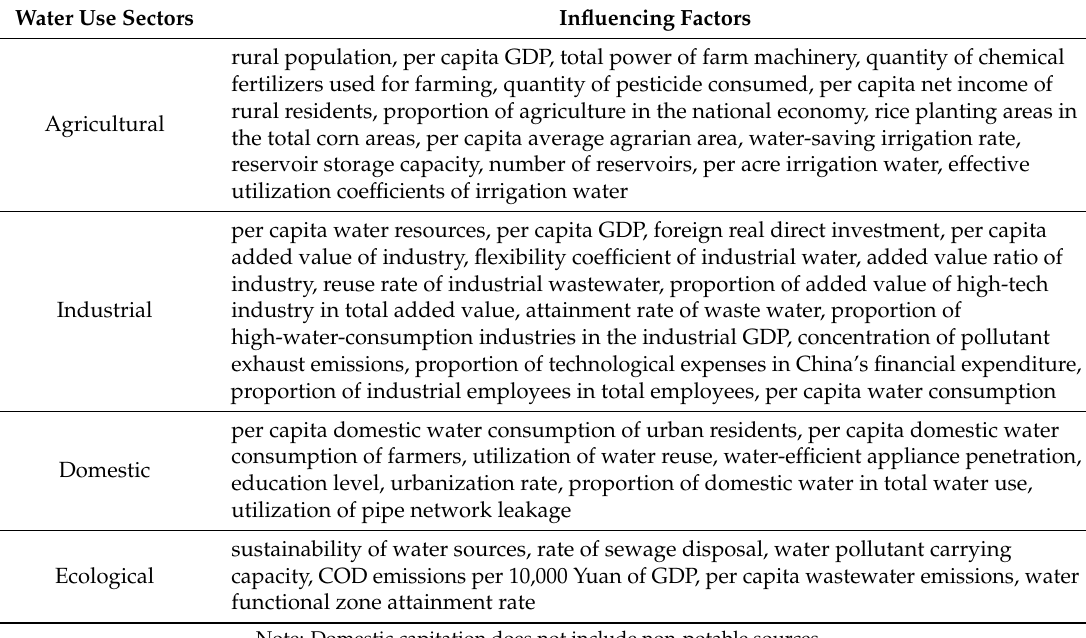
Table 4. Evaluation index system of water usage efficiency control: initial